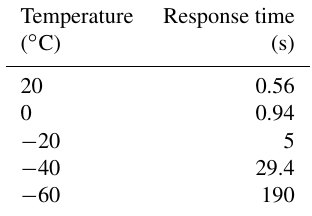
Table B1. Empirically determined response times for the HC103M2 humidity sensor at different temperatures provided by the